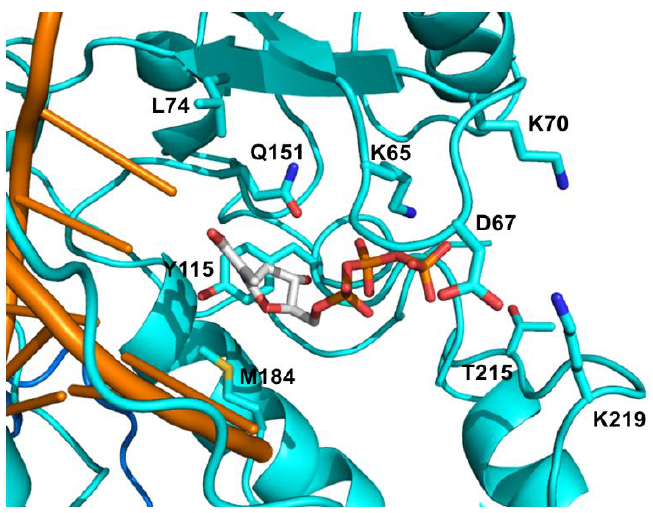
Figure 4. Detailed view of the NRTI binding pocket. The drug resistant mutation sites are shown in cyan sticks. dNTP is highlighted in sticks. PDB 1RTD